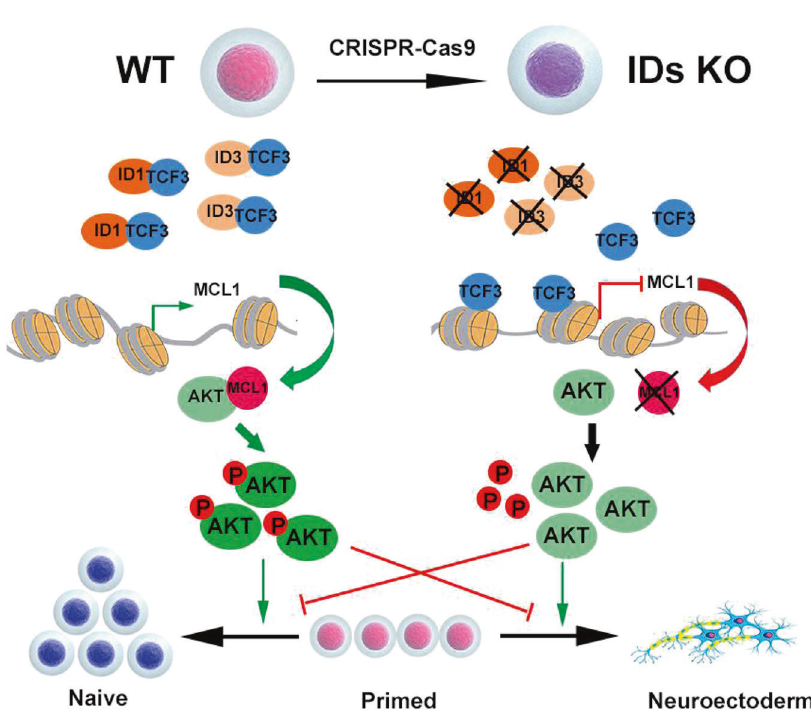
Fig. 8 A model of IDs acting through TCF3 to induce AKT phosphorylation to maintain pluripotency in hESCs. Speci fi cally, IDs KO allows TCF3 to bind to the MCL1 promoter region, which represses its expression and thereby reduces the phosphorylation of AKT in hESCs. Consequently, the reduction in AKT phosphorylation promotes the ectodermal differentiation of primed hESCs and inhibits